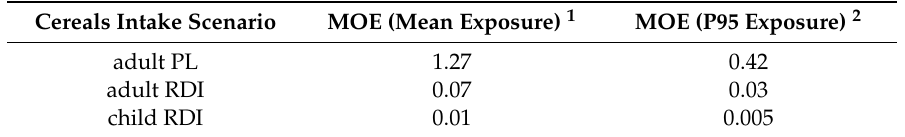
Table 5. Margin of exposure (MOE) values for Pb under the analyzed cereal intake